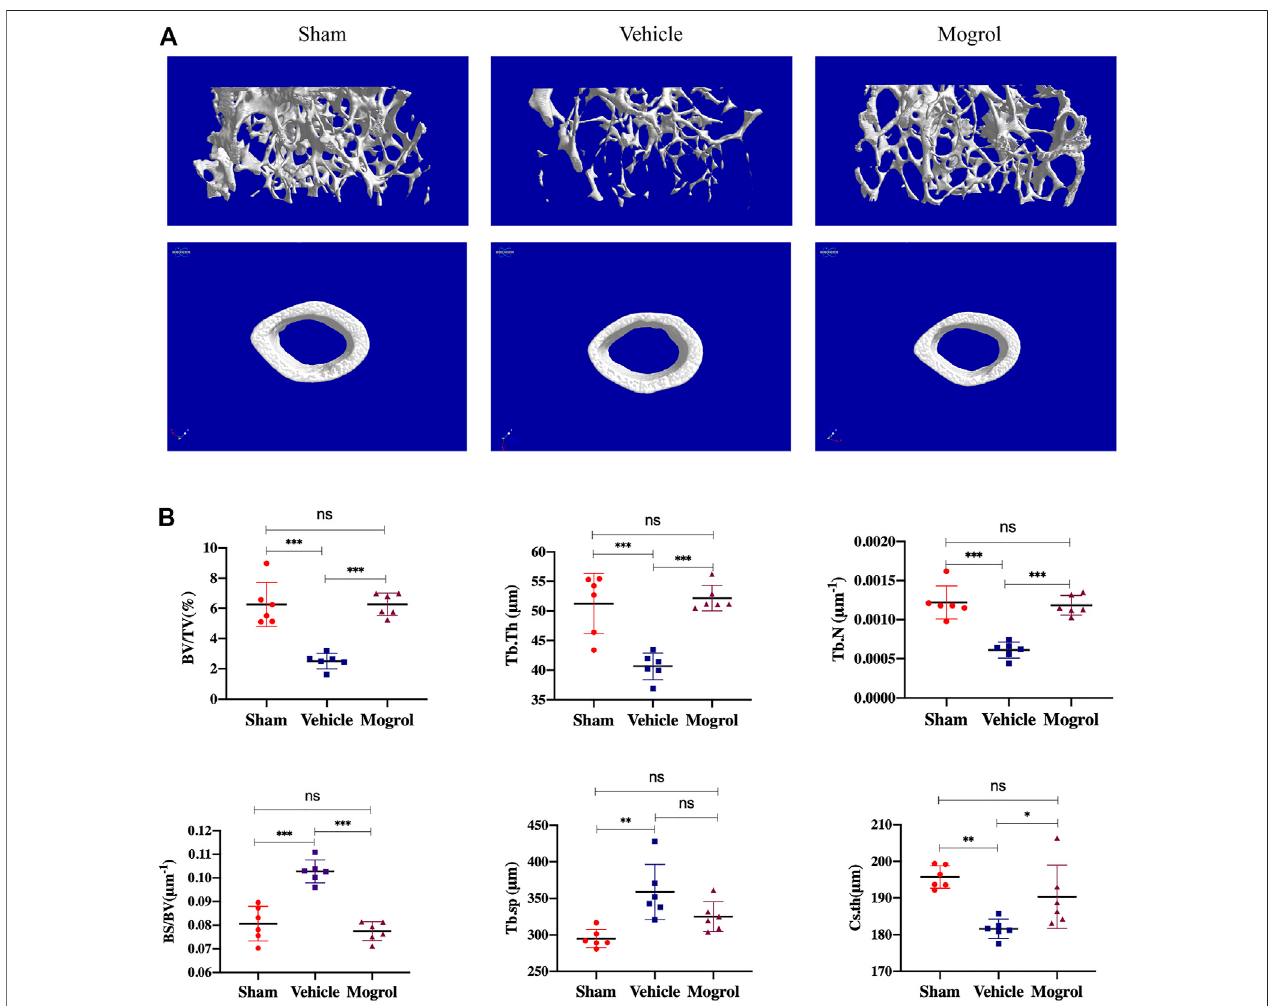
FIGURE 6 | Mogrol inhibited bone mass loss in OVX mice. (A) 3D reconstructions of images from micro-CT scans for femurs from sham, vehicle, and mogrol groups. (B) Bone parameter quantitative analysis, comprising BV/TV, BS/BV, Tb. Th, Tb. N, Tb. Sp, and Cs. th. ( n = 6).